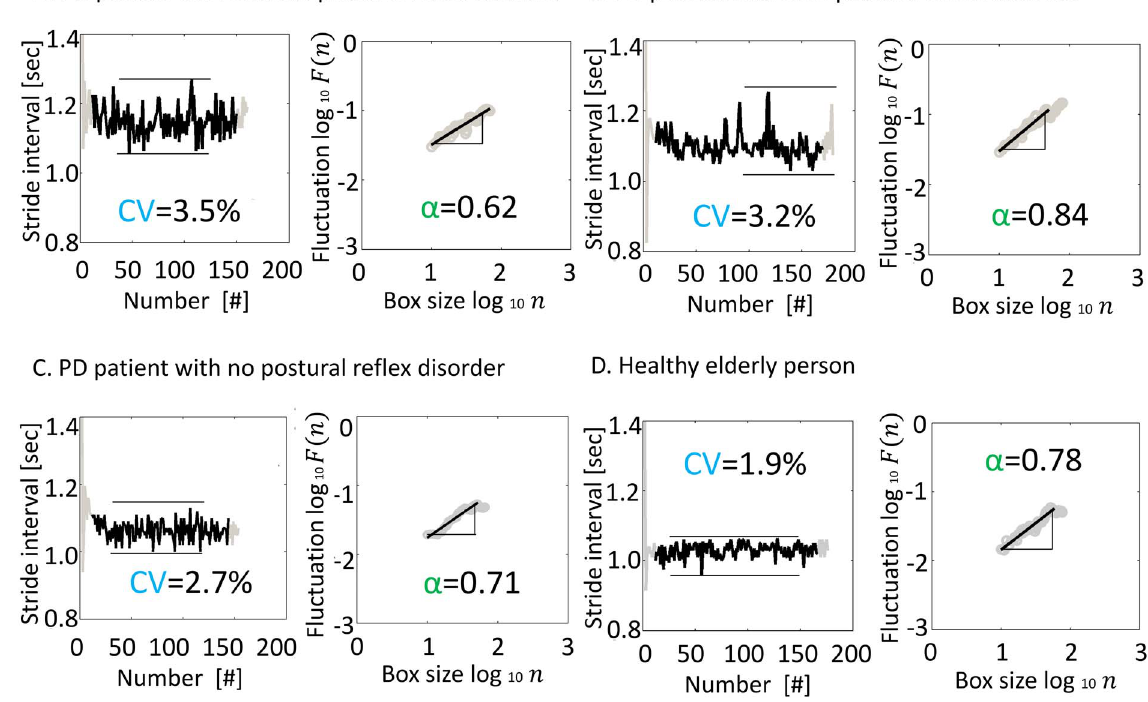
Figure 2. A sample of the stride interval and the fluctuation relative to box size. (A) PD patient with obvious postural reflex disorder (mH-Y score, 3; age 76 years; male). (B) PD patient with mild postural reflex disorder (mH-Y score, 2.5; age, 70 years; male). (C) PD patient with no postural reflex disorder (mH-Y score, 2; age, 76 years; male). (D) Healthy elderly person (age. 71 years; male).